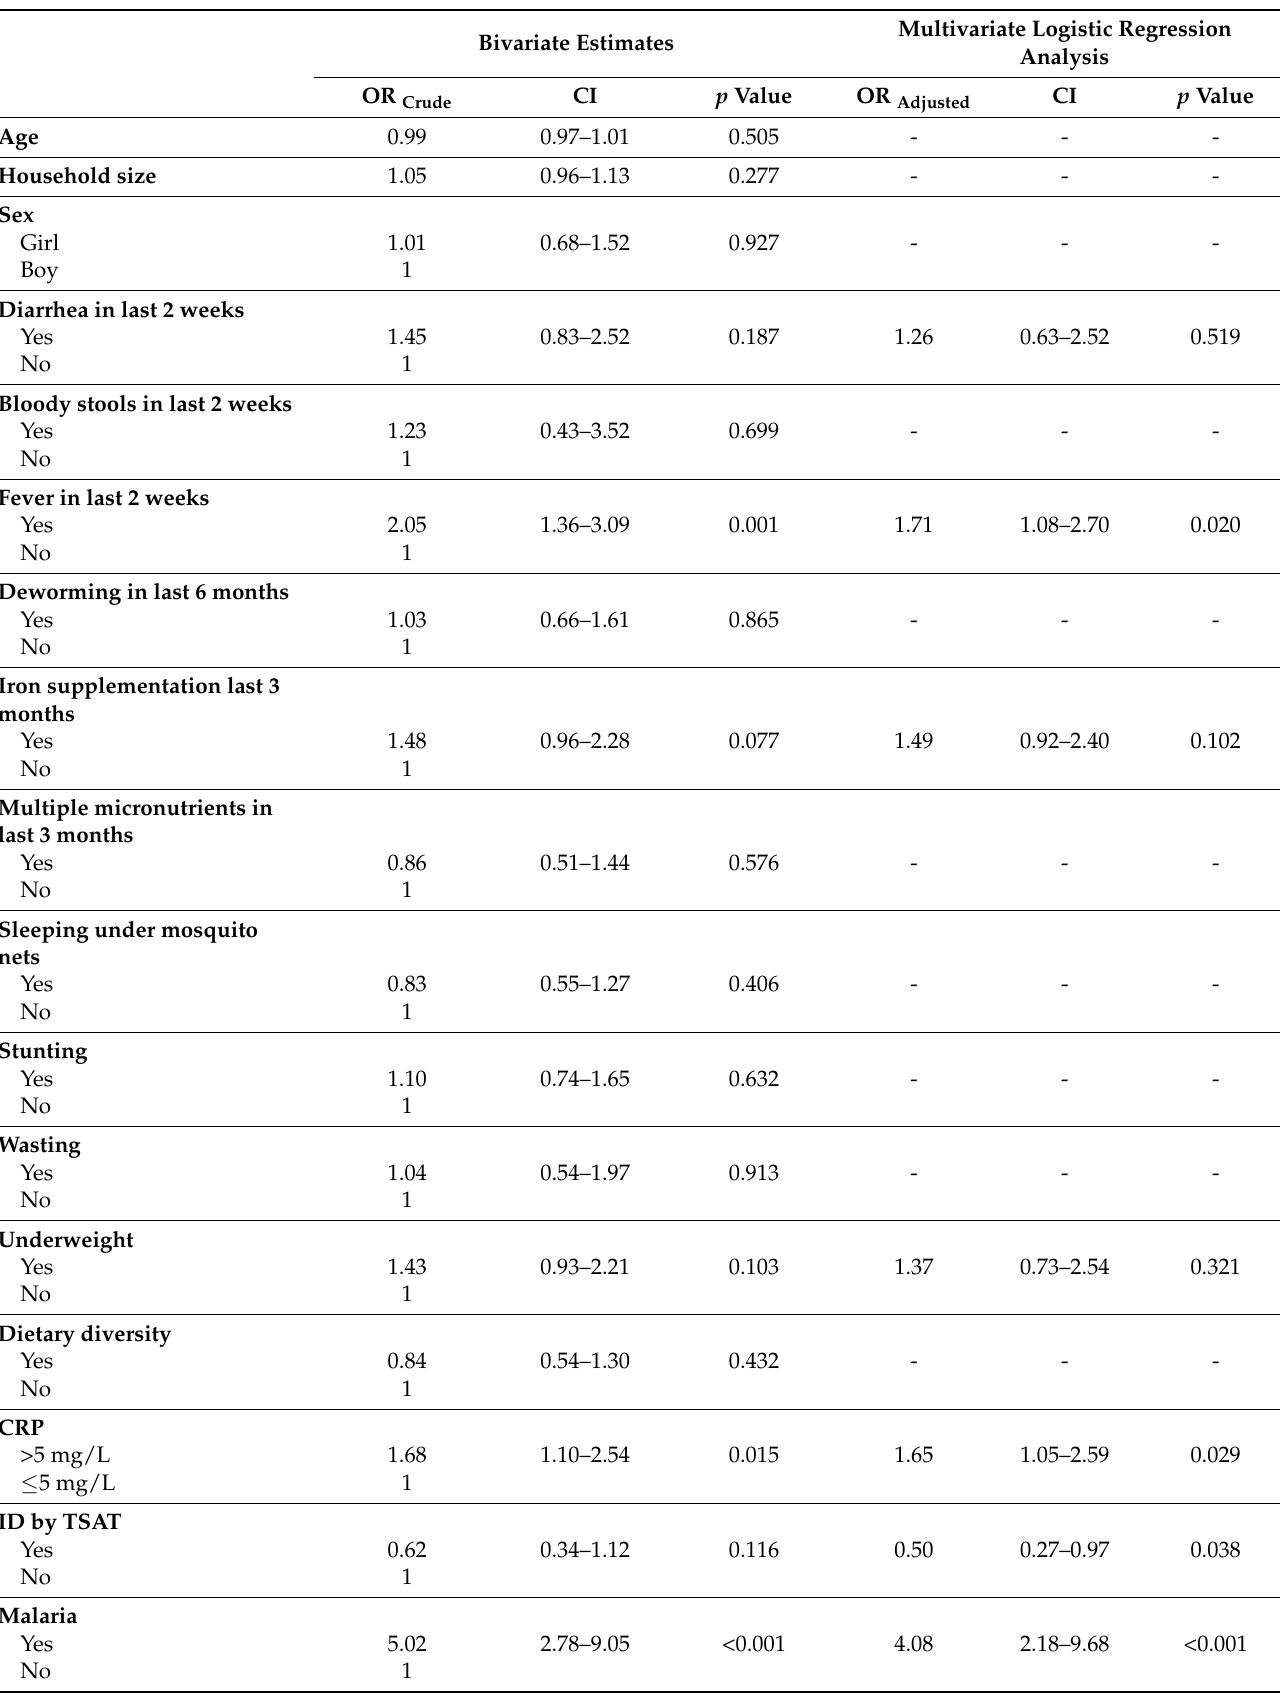
Table A5. Factors associated with anemia, crude and adjusted odds ratios (ORs) reported. Multivariate Logistic Bivariate Estimates